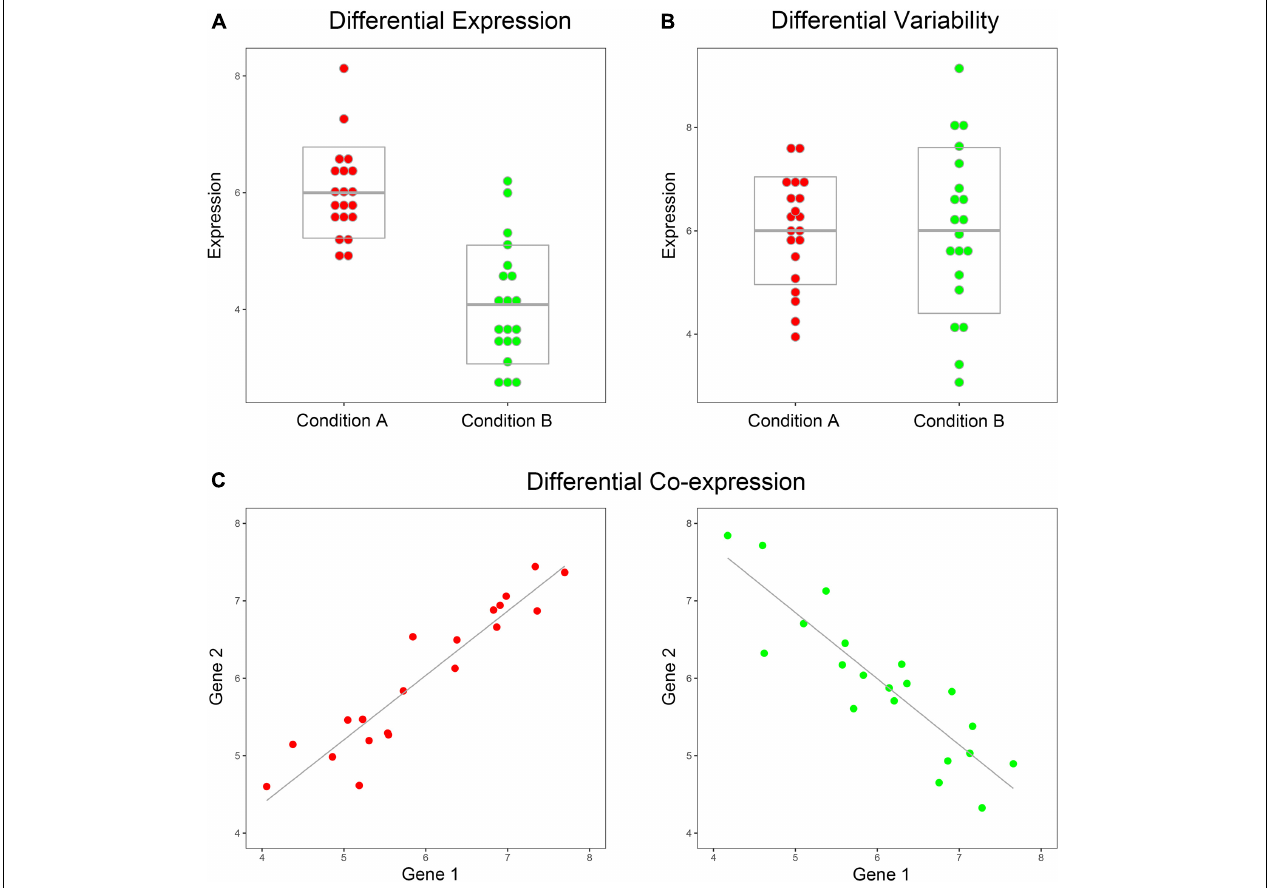
FIGURE 1 | Toy example of DE, DV, and DC. ( A ) The means of gene expression are significantly different between the two conditions, such as case and control, while the variances are similar. ( B ) The variances of gene expression are significantly different between the two conditions, while the means are similar. ( C ) The correlation coefficients of the two genes are significantly different between the two